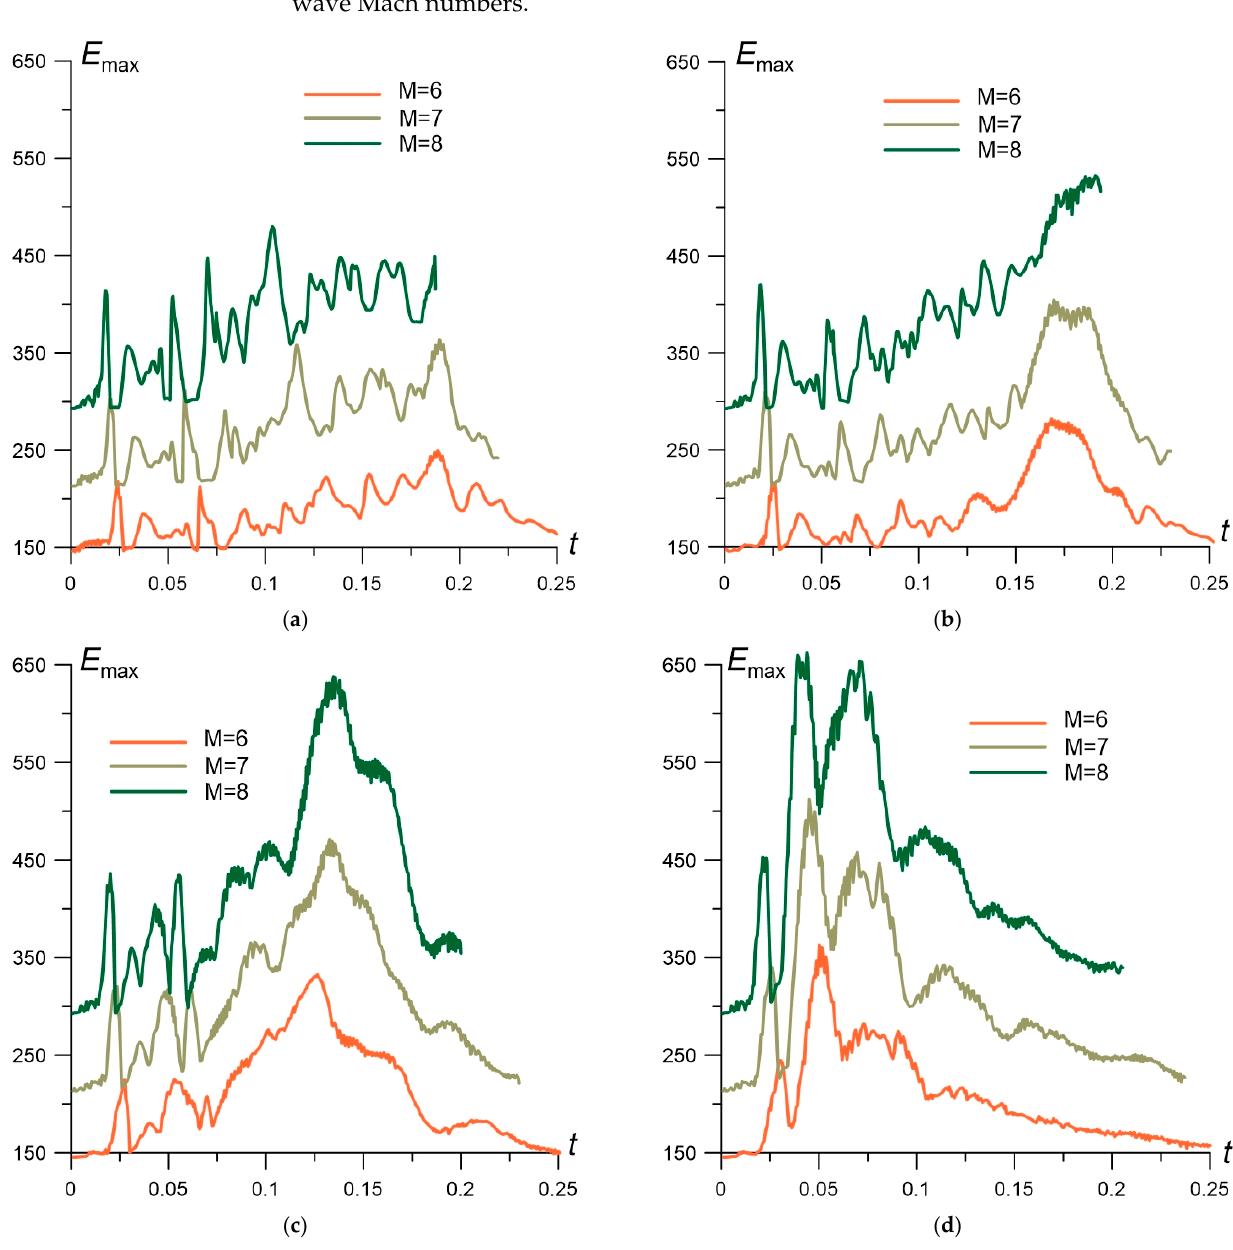
Figure 13. Dynamics of E max for different M: ( a ) α = 0.1; ( b ) α = 0.2; ( c ) α = 0.3; ( d ) α = 0.4.